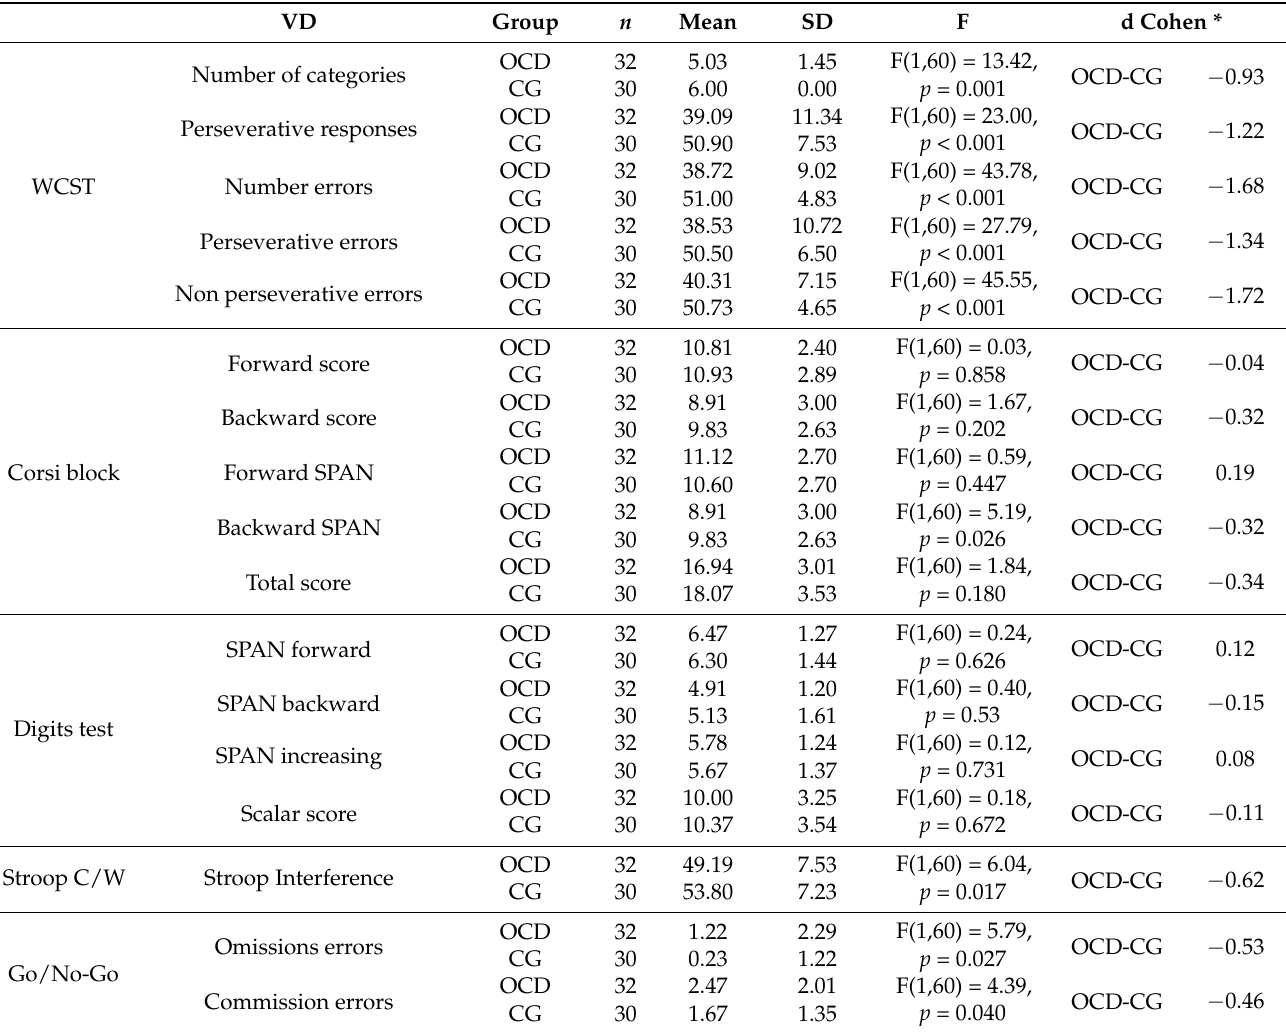
Table 2. MANOVA and ES in CF, IR, and